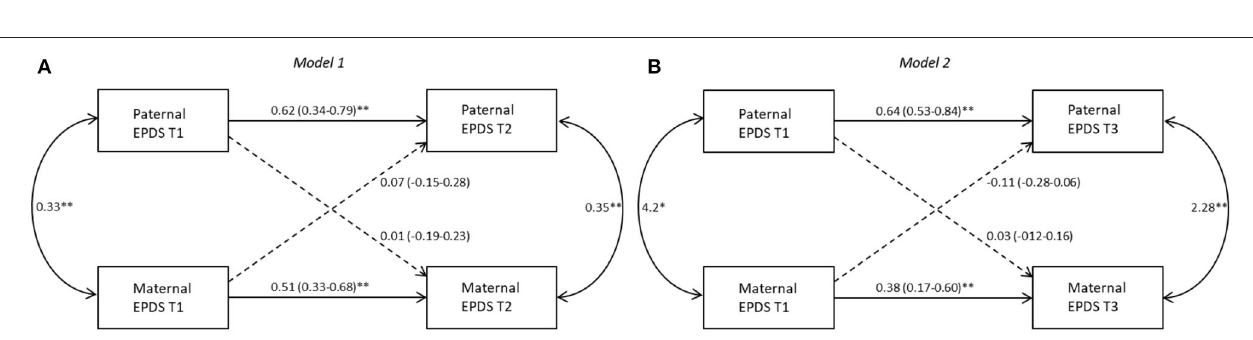
FIGURE 3 | Actor-partner interdependence models for depression in FT group 95% CI are reported in parentheses; * p ≤ 0.05; ** p ≤ 0.01. Note . (A) Model 1: T1D- > T2D, (B) Model 2: T1D- > T3D. Black lines represent significant paths, dashed lines represent non-significant